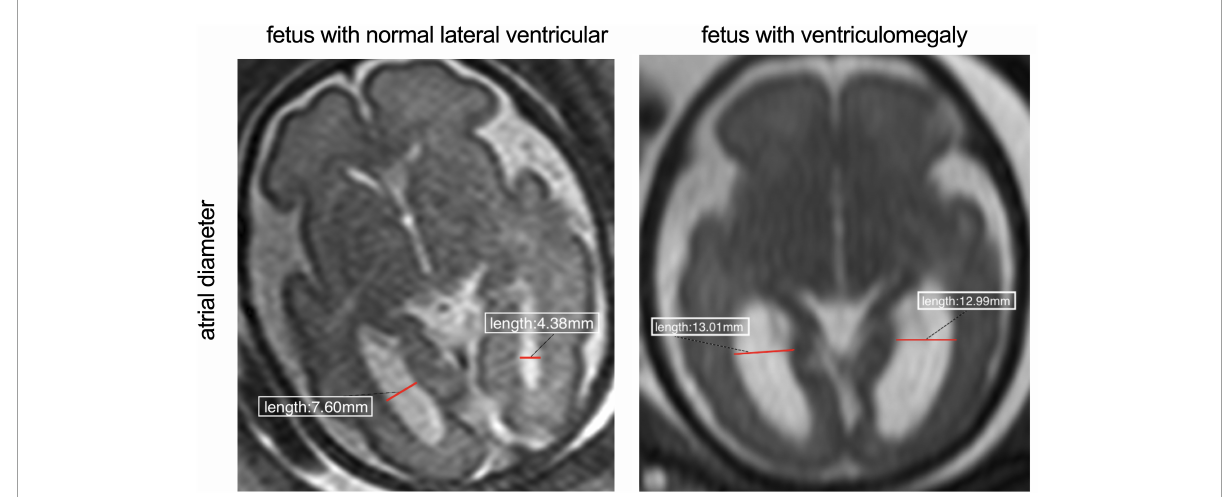
FIGURE1 Comparison between fetus with normal lateral ventricular and wider ventricle. The red line indicates the width of the atrial diameter.